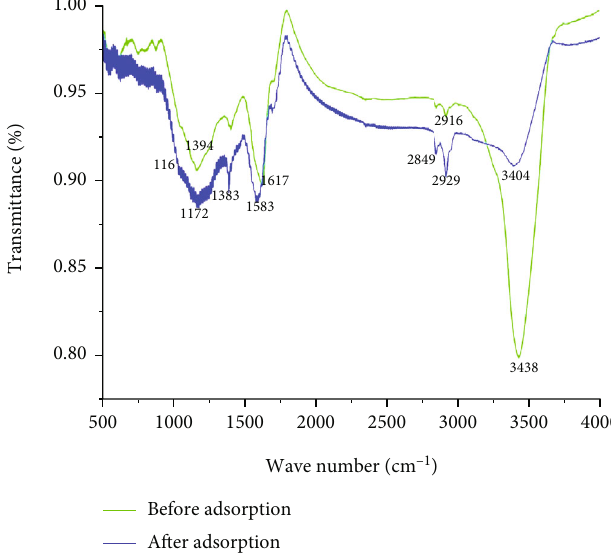
Figure 12: FTIR spectrum of activated co ff ee husk carbon before and after adsorption.